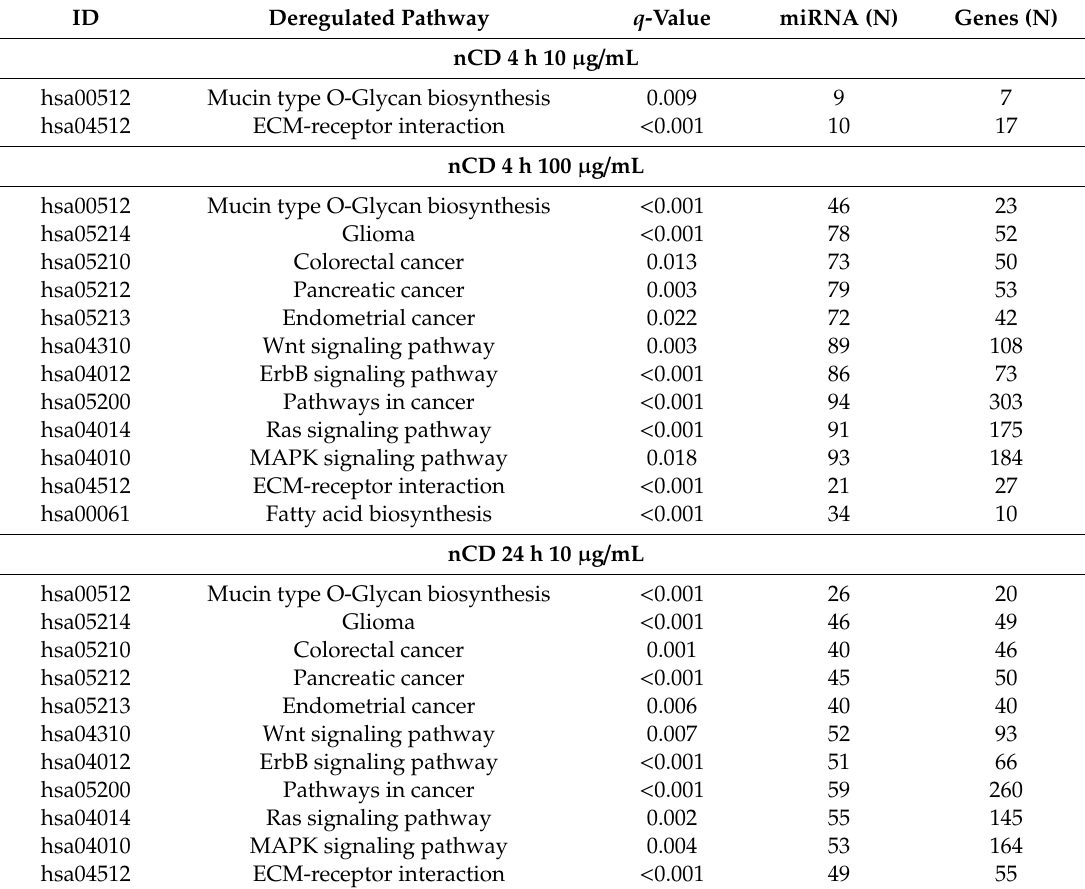
Table 4. Selected pathways based on miRNA-mRNA interactions deregulated after nCD NPs